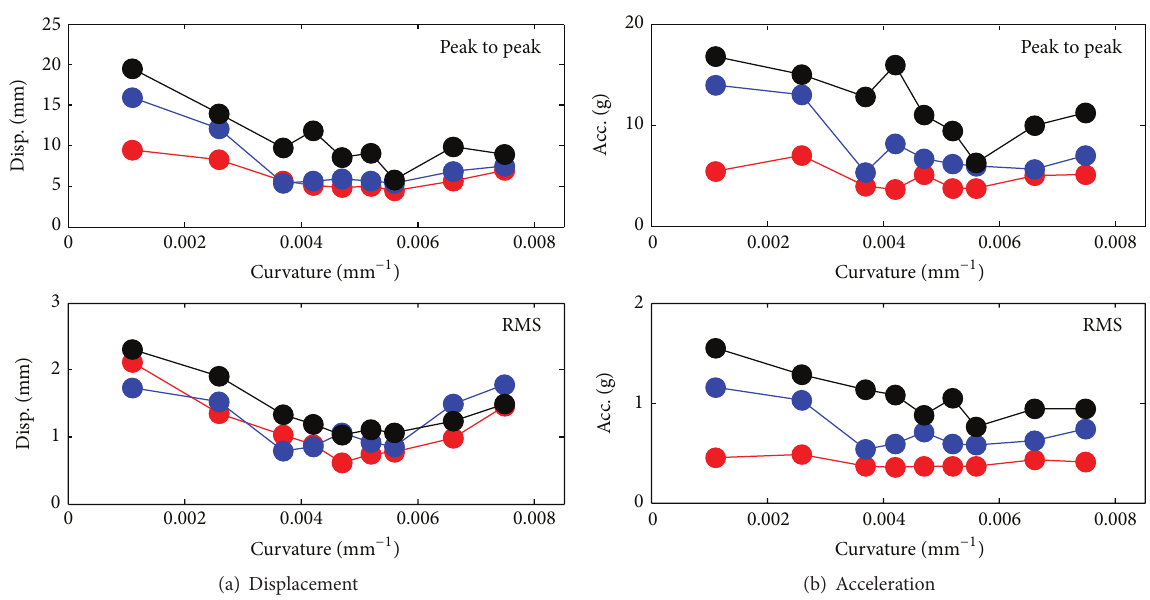
Figure 7: Simulation results of the vehicle vibrations with respect to nine curvatures of rollers and three driving speeds of the vehicle. (a) Displacement and (b) acceleration (red, blue, and black lines indicate low, mid, and high speed, resp., and top and bottom figures indicate peak to peak and RMS values,